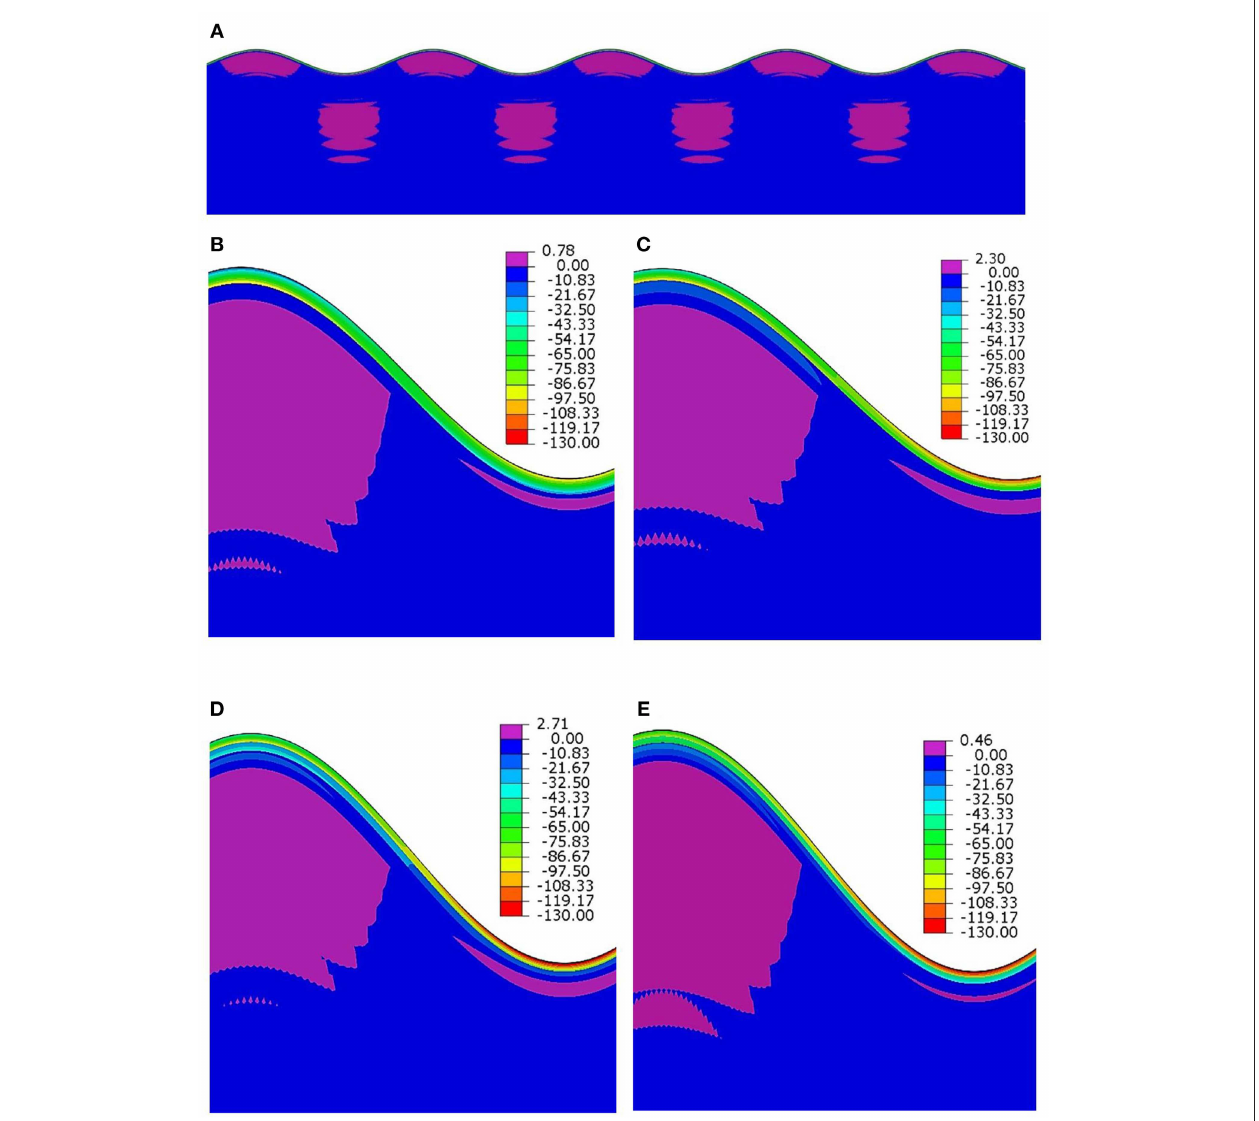
= 1.10 in all cases. (Deformations in cr